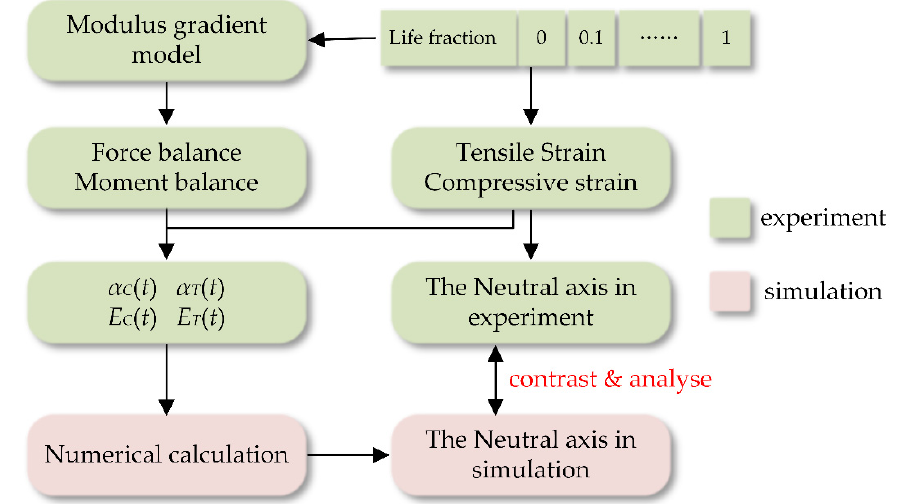
Figure 3. Logic diagram of bone bimodule gradient model.